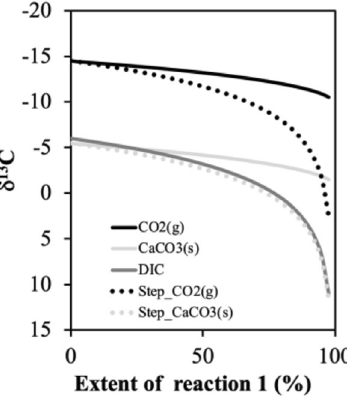
Figure 3. Evolution in δ 13 C values of CaCO 3 and CO 2 is modelled assuming Rayleigh fractionation, as DIC and Ca 2+ in the irrigation water slowly precipitate out according to chemical reaction (1) with initial δ 13 C DIC at − 6‰. Isotopic composition is plotted as dotted lines for each step or as solid lines cumulatively, for each species (black for CO 2 (g), grey for CaCO 3 (s) and dark grey for DIC). When all DIC is converted to calcite and CO 2 , extent of the reaction moves from 0 to 100%, and the carbon isotopes of these endmembers are derived ( δ 13